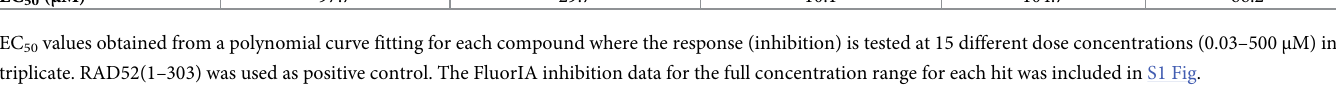
triplicate. RAD52(1–303) was used as positive control. The FluorIA inhibition data for the full concentration range for each hit was included in S1